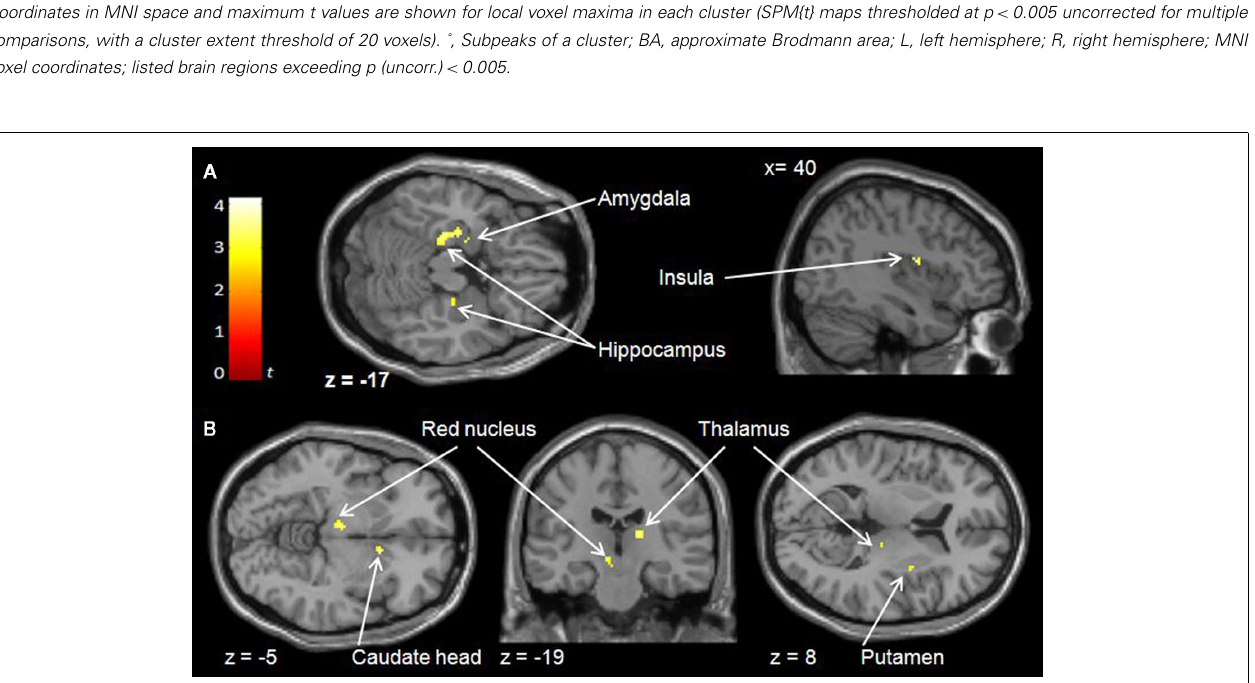
FIGURE 5 | Effects of category change in the avatar-to-human direction (A) and human-to-avatar direction (B) along continua of human